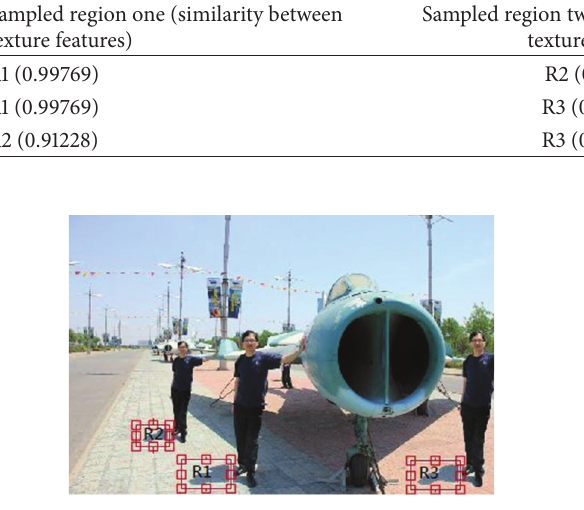
Figure 10: Examples of forged image with